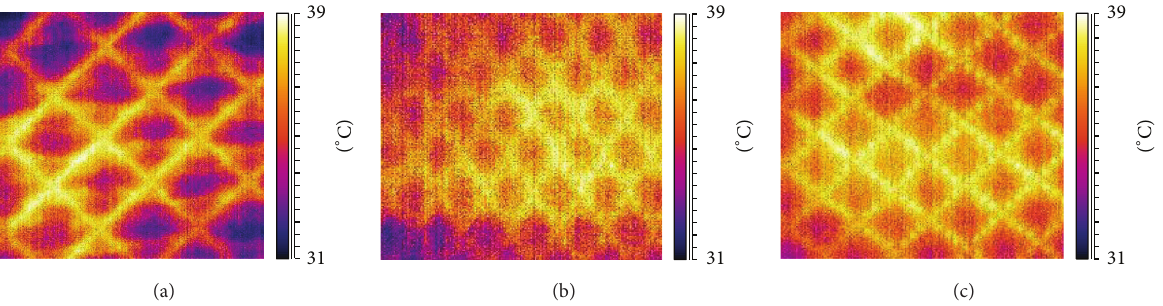
Figure 7: IR images of CO piqu´e fabrics: (a) CO-6 ( 𝜌 = 301 kg/m 3 ), (b) CO-7 ( 𝜌 = 353 kg/m 3 ), and (c) CO-8 ( 𝜌 = 338 kg/m 3 ).